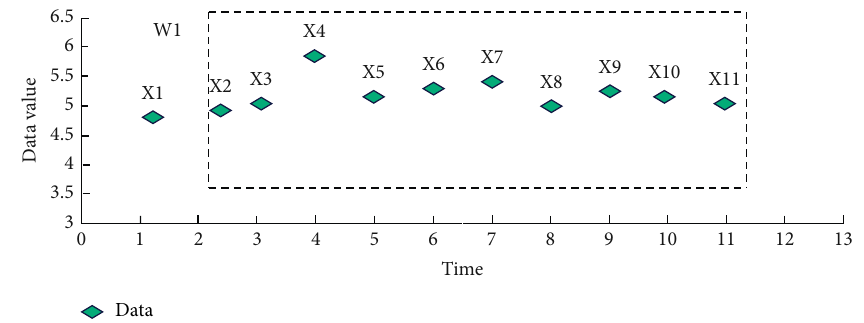
Figure 1: Outlier case within the